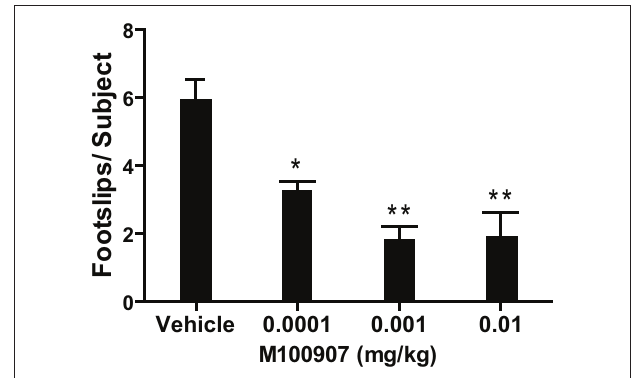
Figure 2 | M100907 relieved motor deficits in MPTP-treated mice. MPTP-treated mice received vehicle or various doses of M100907. Data are presented as mean ± SEM. M100907 dose-dependently reduced the number of footslips in MPTP-treated mice. * p < 0.05, ** p < 0.01; relative to saline-injected controls; in one-way ANOVA with Tukey’s post